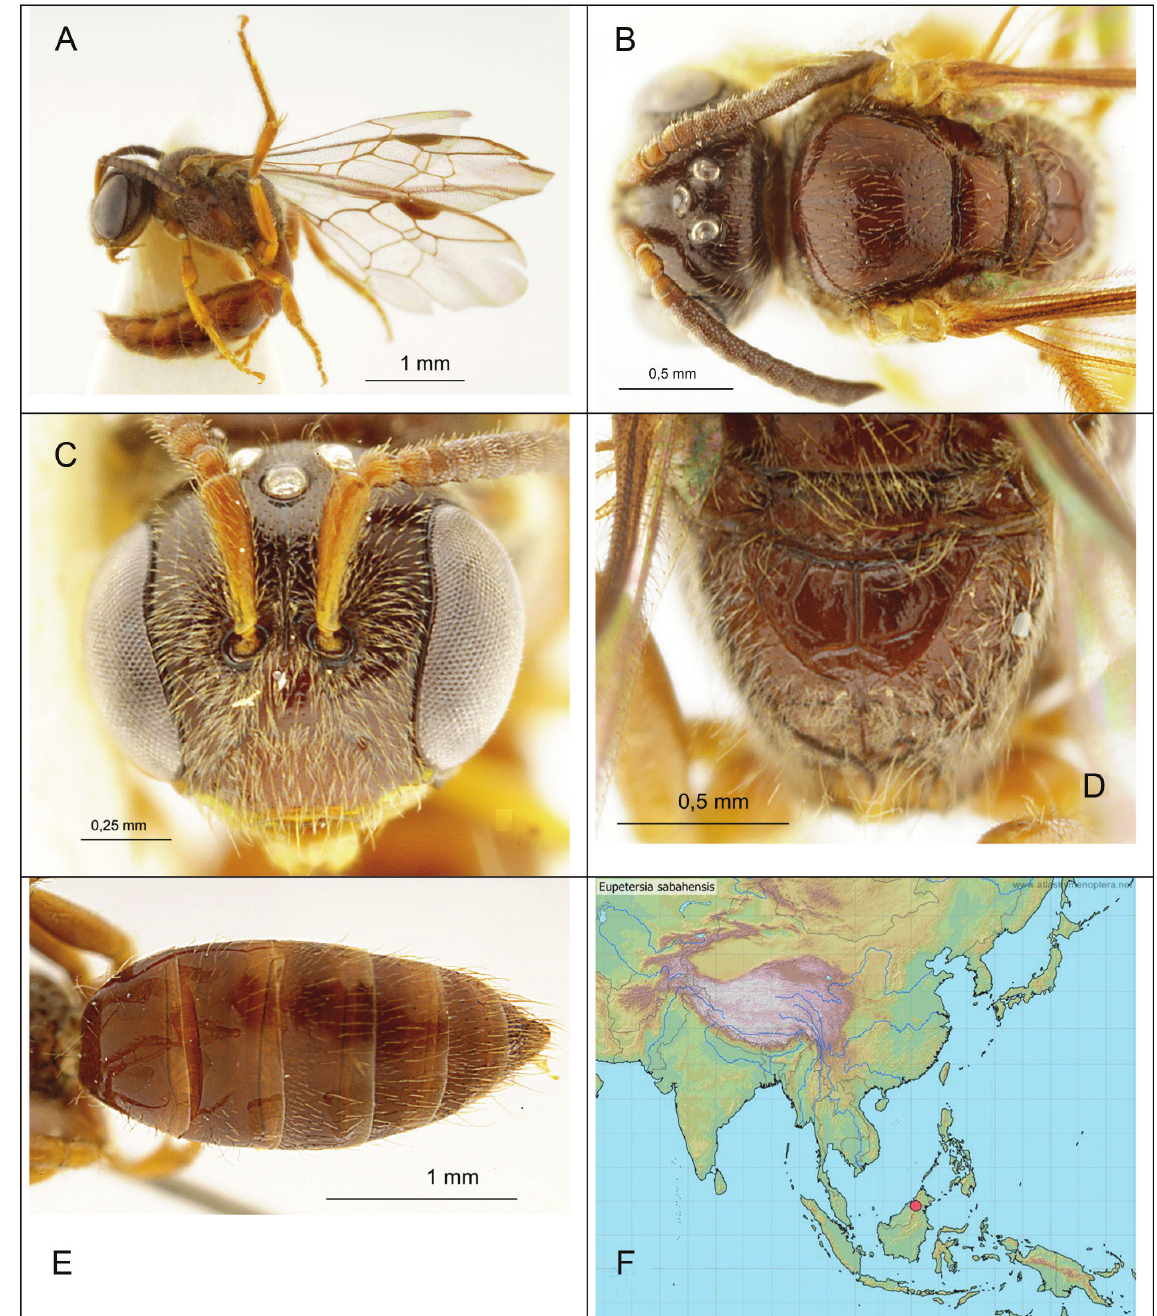
Fig. 2. Eupetersia sabahensis sp. nov., ♂ holotype. A . Lateral habitus. B . Dorsal view of head and mesosoma. C . Facial view. D . Propodeum. E . Metasoma. F . Geographic